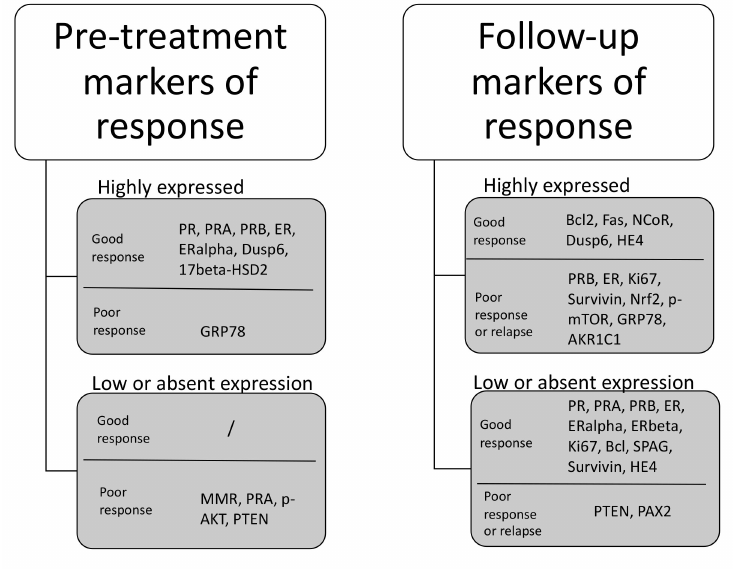
Figure 2. Summary of statistically significant immunohistochemical markers for conservative management